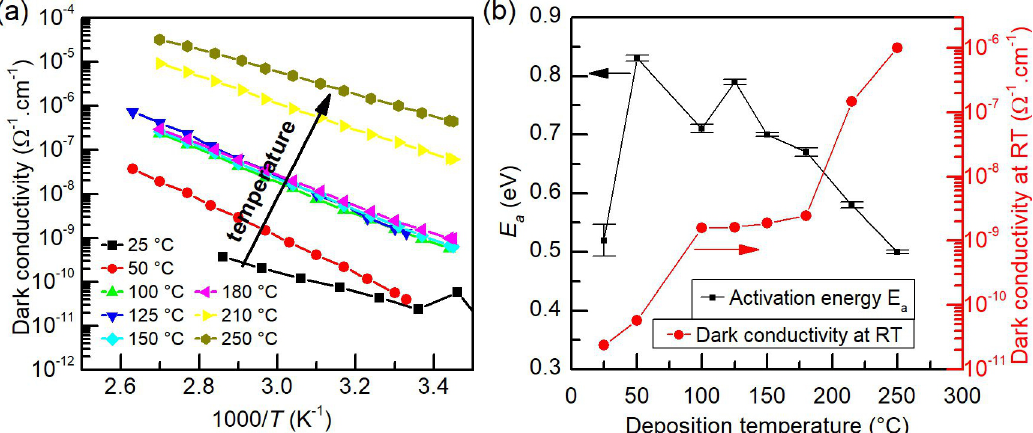
Figure 2. ( a ) Arrhenius plot of dark conductivity for a-Si:H films deposited at various temperatures in the range of 25 ◦ C to 250 ◦ C; and ( b ) the dependence of activation energy E a and room-temperature dark conductivity on the deposition temperature (the error bars represent the standard error of the linear regression of the data sets in (a)). The lines between the points are drawn to guide the